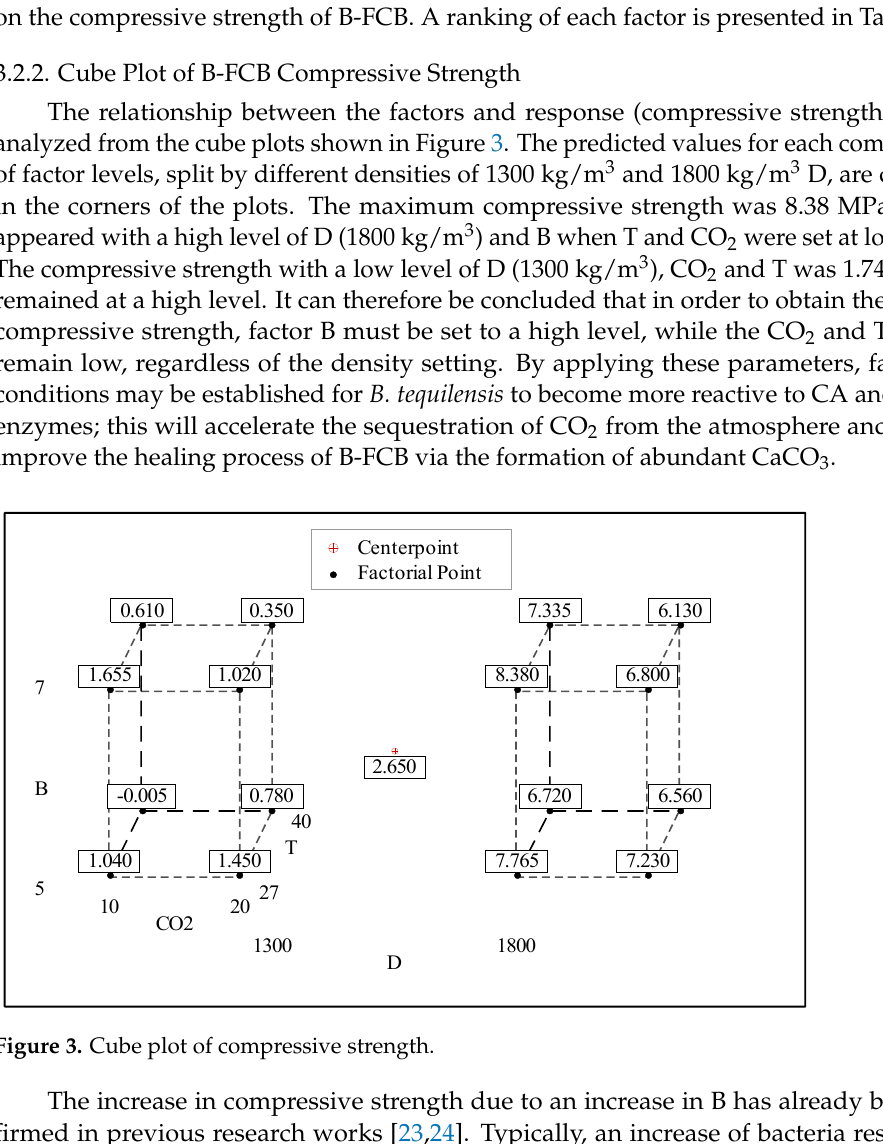
Table 7. Results of the full design of RSM for compressive strength and carbonation depth.